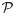
Scatterplots of the first attended locations P predicted by the saliency algorithms.A: P for target-present images in the Potter set. B: P for images with no target present from Potter set. C: P for target-present images in the Thorpe set. D: P for images with no target present from Thorpe set.